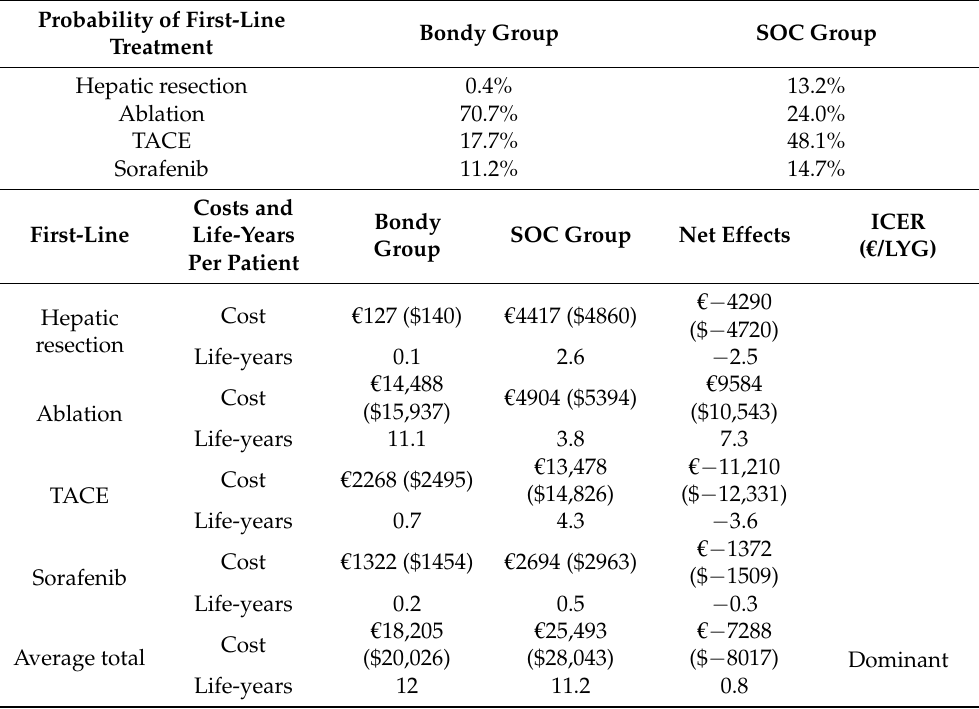
Table 2. Baseline results of cost-effectiveness analyses by first-line treatment. These results were weighted by the probabilities of each first-line treatment in the Bondy and standard of care groups and used to calculate the final